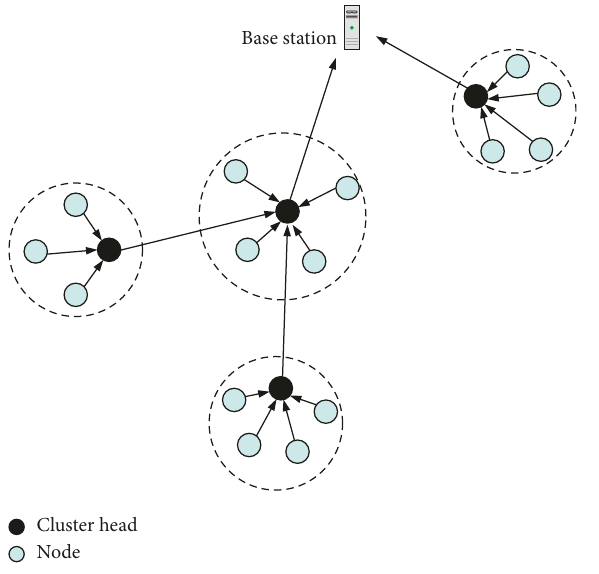
Figure 11: Data transmission multihop